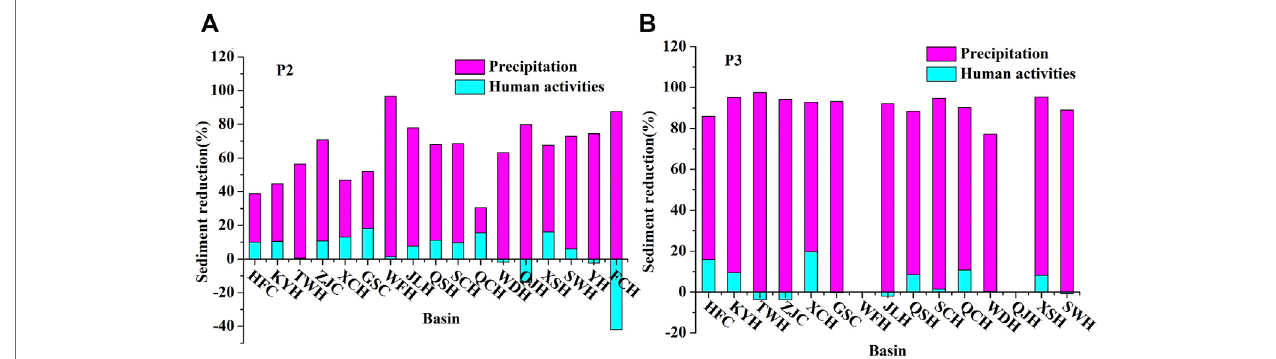
FIGURE 6 | Sediment reduction due to precipitation and human activities in (A) P2 and (B) P3